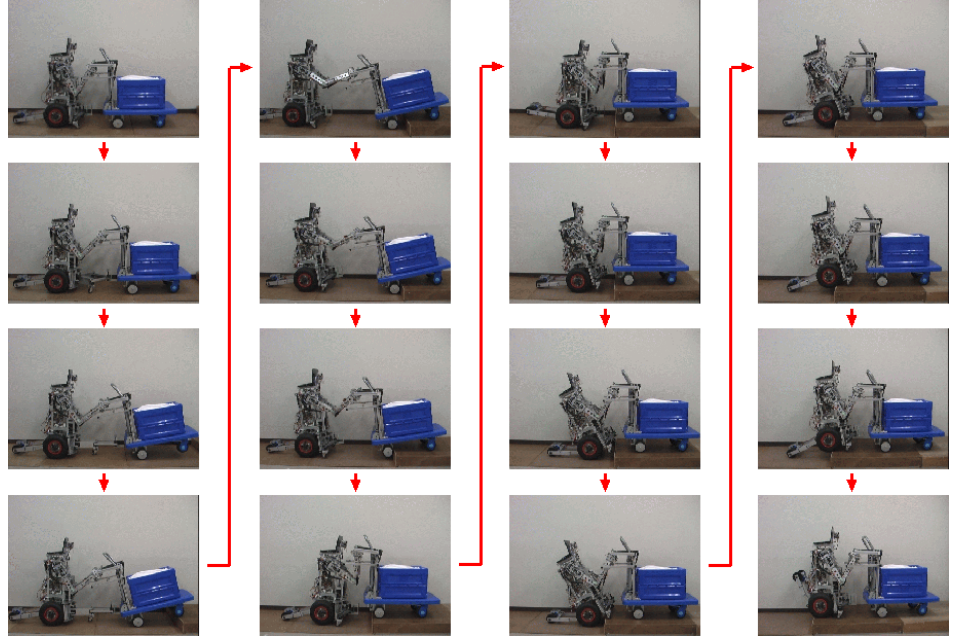
Figure 18. Step-climbing experiment using the robot and the hand cart